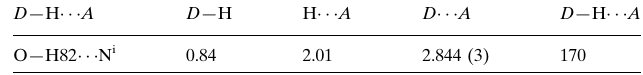
Hydrogen-bond geometry (A˚ , (cid:4)